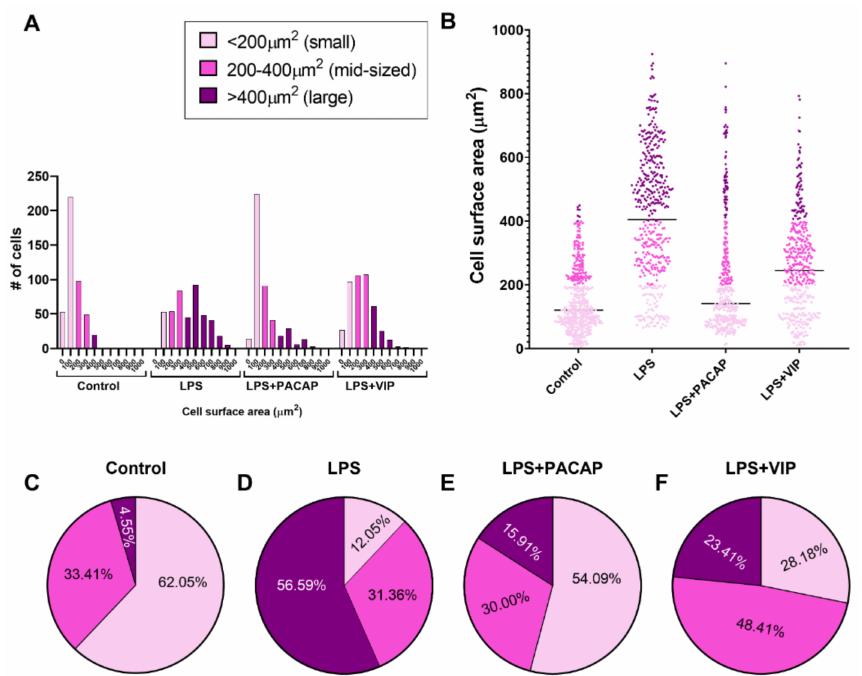
Figure 7. Redistribution of BV2 cell subpopulations based on cell surface area after treatment with LPS or in combination with PACAP or VIP. BV2 cells plated at 5 × 10 5 in 25 cm 2 flasks were starved with 1% FGM for 24 h prior to treatment with 10% FGM (control), 1.0 µ g/mL LPS, 1.0 µ g/mL LPS + PACAP 100 nM and 1.0 µ g/mL LPS + VIP 100 nM for 24 h; then, images were captured using Nikon Eclipse Ts2 inverted microscope. Images were assigned to investigators who were blind to experimental conditions and cells were classified as either small (<200 µ m 2 ), mid-sized (200–400 µ m 2 ) or large (> 400 µ m 2 ) (please refer to Table 1 for further details on cells characteristics). Analyses were performed using Image J 1.51 (NIH) software. Measurements of cell surface area were performed on a total of 1760 cells (440 cells × treatment group). ( A ) Distribution of cell populations based on cell surface area identify distinct patterns across treatments. ( B ) Scatter plot of cell surface area distribution in each treatment group (the black line depicts the median). ( C – F ) Pie charts showing the percentage of distribution of cell populations after ranking into small, mid-sized or large